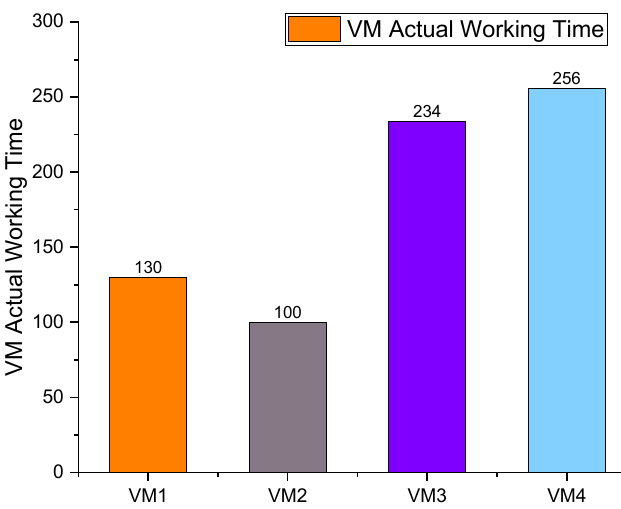
Figure 11. Actual working time of VMs.